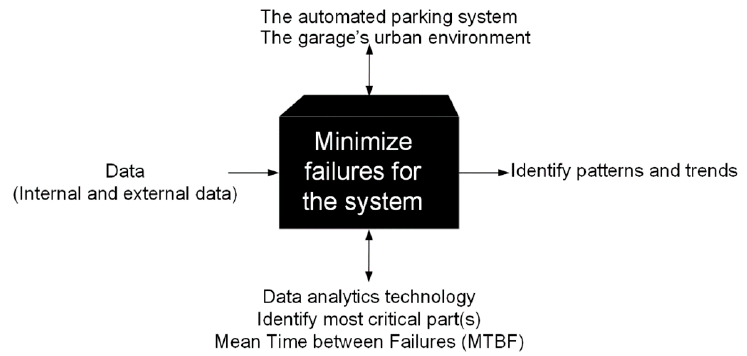
Figure 14. Black Box.